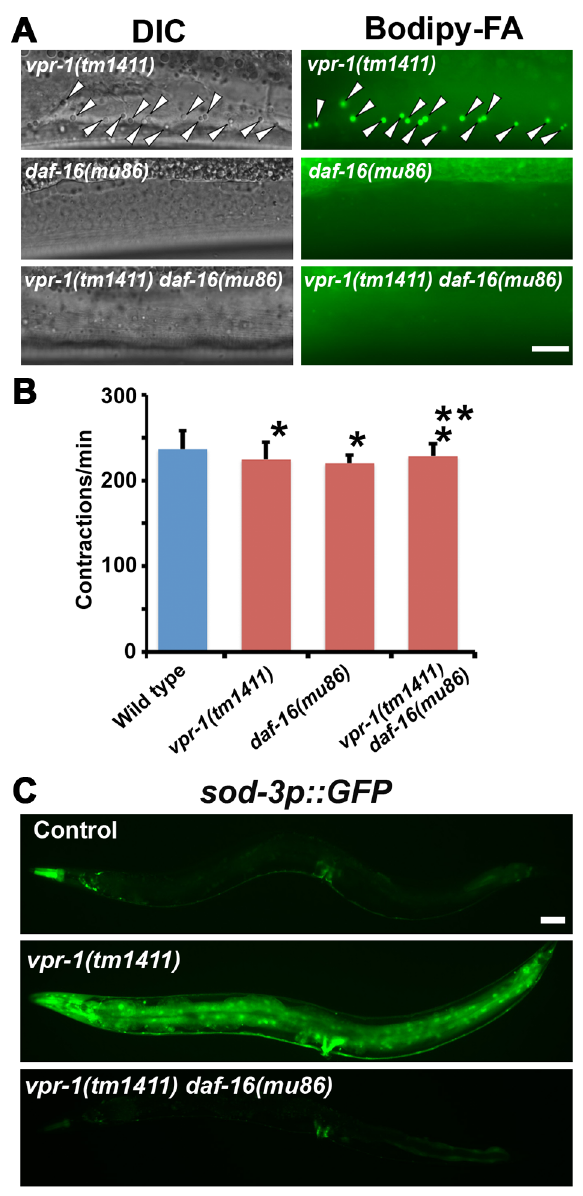
Figure 5. DAF-16 activity in vpr-1 mutants. (A) DIC and fluorescent images of muscle in live 3-day-old hermaphrodite worms fed Bodipy- FAs. Arrowheads indicate Bodipy-FA-stained droplets. Wild-type con- trols (not shown) are similar to daf-16(mu86) mutants (See figures 1C and 4). Bar, 5 m m. (B) Pharyngeal pumping rates of 1-day-old adult hermaphrodites. Wild type (236.7 6 21.1 [n=11]) and vpr-1(tm1411) mutants (220.1 6 9.6 [n=11]) have similar pharyngeal pumping rate. Error bars represent SD. * P . 0.05 compared to wild type. ** P . 0.05 compared to vpr-1(tm1411) mutant. (C) Transgenic worms expressing GFP under control of the sod-3 promoter, a direct DAF-16/FoxO target. Anterior is to the left in all panels. Bar, 50 m m.